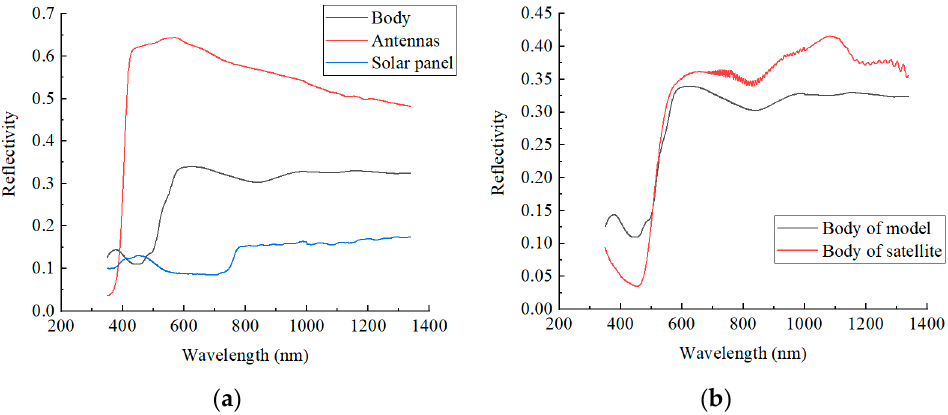
Figure 6. Spectral reflective properties of the models: ( a ) spectral reflectance curves for the three main parts of the satellite model, including the body, antenna, and solar panels; ( b ) the spectral reflectance curves of the satellite model body compared to the real satellite.